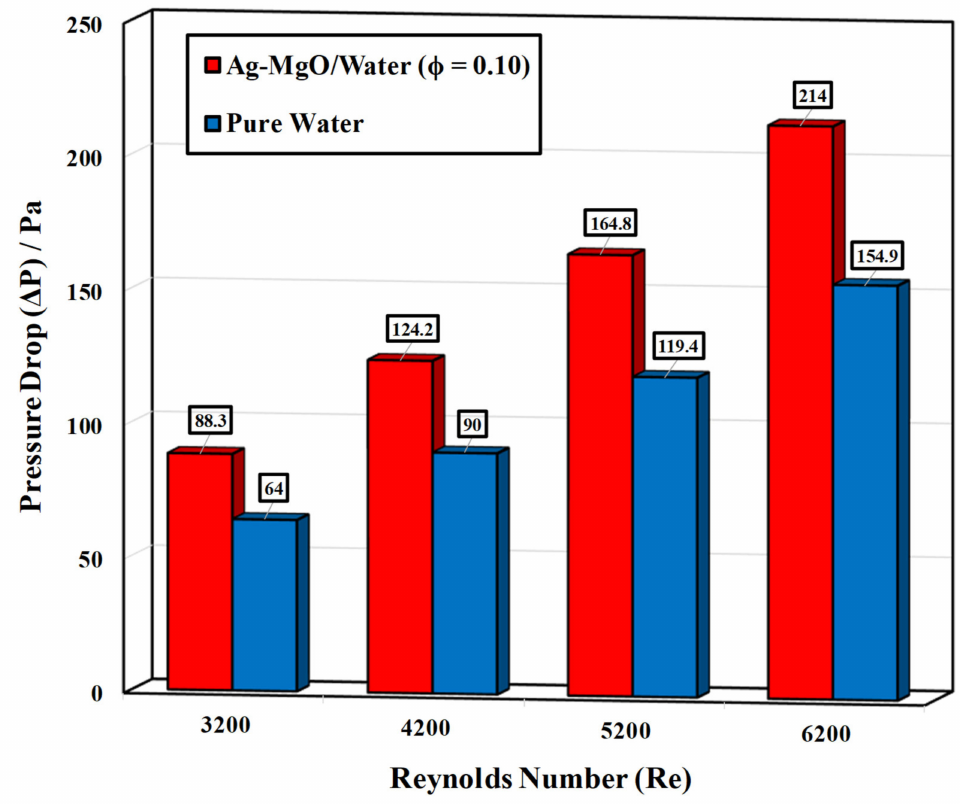
Figure 19. Pressure drop when using Ag-MgO/Water hybrid nanofluid with different Reynolds numbers at φ =